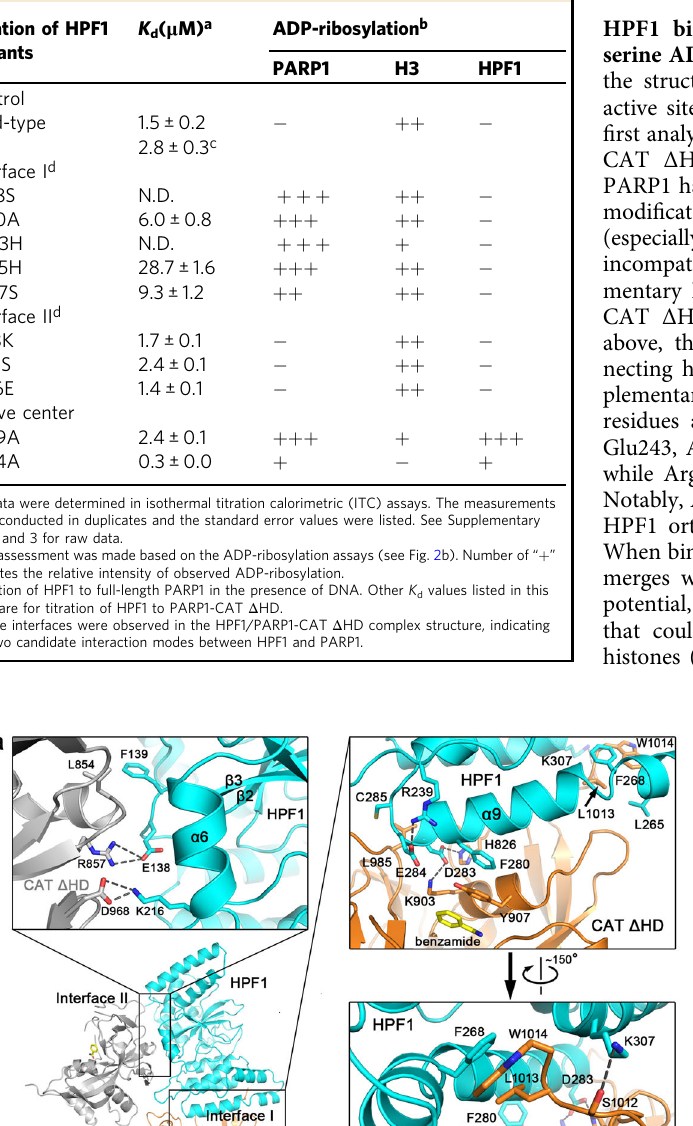
Table 1 Dissociation constant ( K d ) of HPF1 mutants binding to PARP1 CAT Δ HD and their effects on ADP-ribosylation of full-length PARP1 (automodi fi cation), histone H3, and